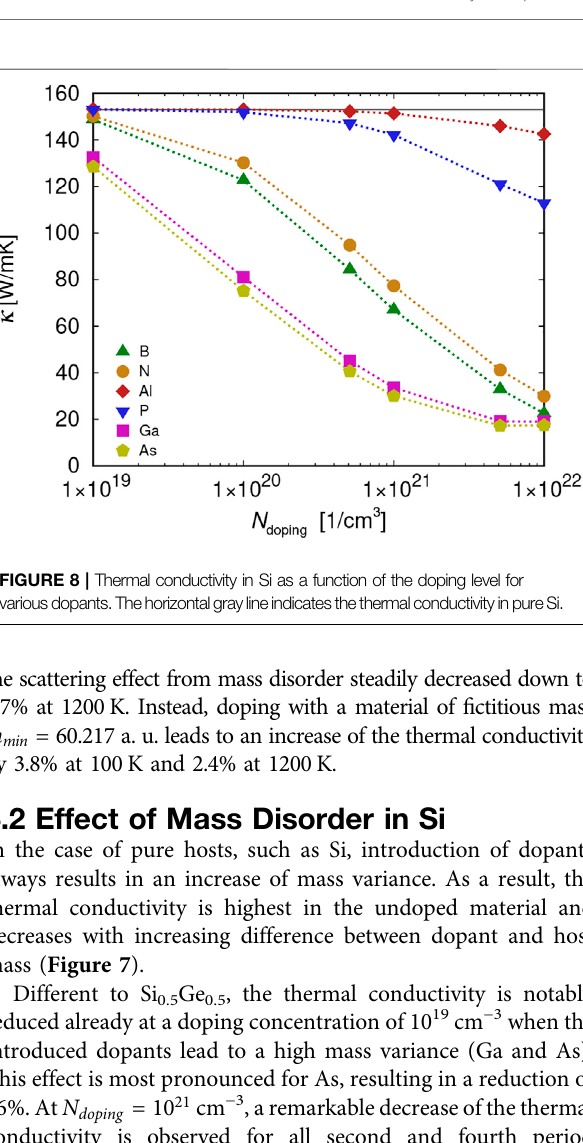
Frontiers in Mechanical Engineering |